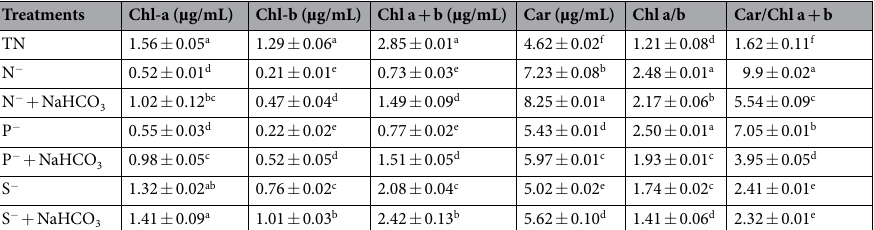
Figure 1C represents the effect of bicarbonate amendment on biomass of Dunaliella cultures under nutrient deficit condition. Removal of macronutrient from the growth medium significantly affected the metabolic pro- cess of Dunaliella and resulted in lower biomass (N − –0.42 ± 0.01 g/l and P – –0.58 ± 0.01 g/l), whereas biomass production of D. salina remained largely unaffected in S − (1.08 ± 0.01 g/l) and S − + NaHCO 3 (1.14 ± 0.16 g/l) as compared to the total nutrient cultures (1.37 ± 0.11 g/l). However, addition of bicarbonate on the macronutrient deficit medium (N − + NaHCO 3 –0.92 ± 0.03 g/l, P − + NaHCO 3 –0.94 ± 0.01 g/l, S − + NaHCO 3 –1.14 ± 0.16 g/l) significantly enhanced the biomass of D. salina , which indicates the active utilization of bicarbonate for the growth and metabolic process of microalgae under stress conditions. The effect of bicarbonate on photosynthesis efficiency (F v /F m ) of Dunaliella cultures under nutrient deficit conditions were presented in Fig. 1D. Maximum photosynthesis efficiency was observed in the nutrient deficit Dunaliella cultures amended with bicarbonate, whereas all nutrient deficit cultures (N − , P − and S − ) showed decreased photosynthetic efficiency compared to